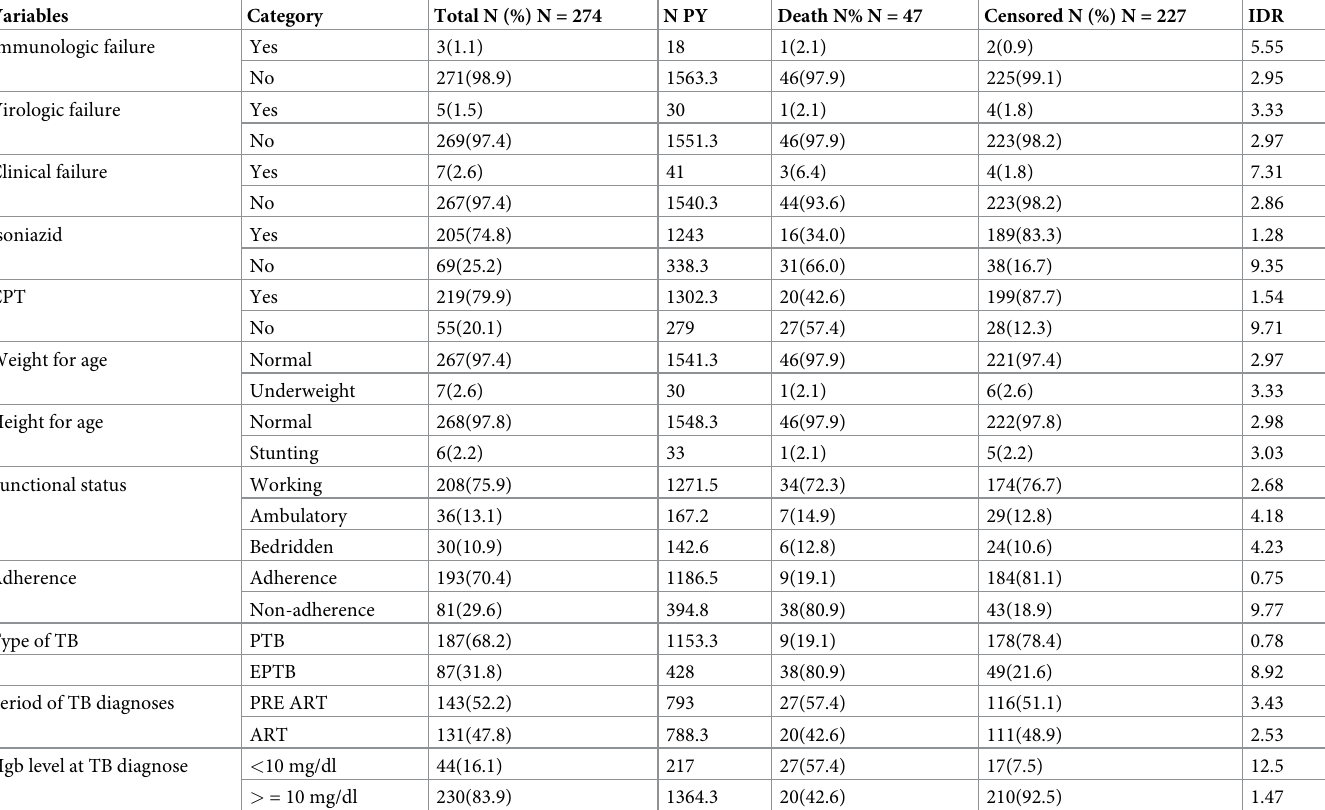
Table 3. Medication and disease related characteristics of TB/HIV co-infected children at public hospitals Southern Ethiopia, 2020.